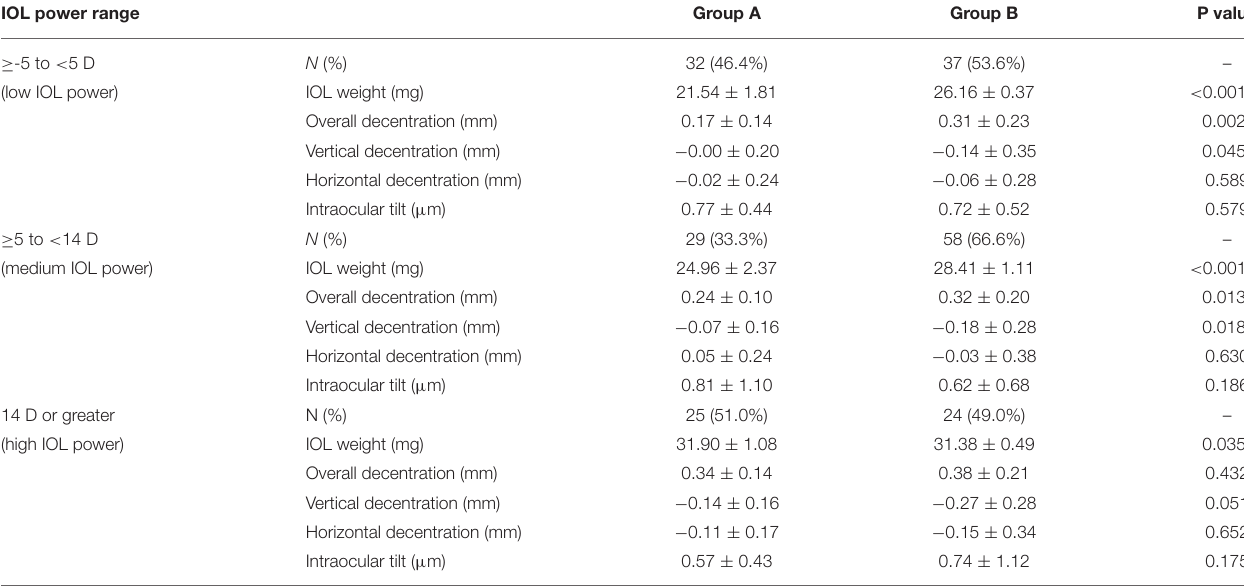
TABLE 2 | Comparisons of long-term intraocular lens (IOL) stability between Groups A and B with 3 different IOL power ranges. IOL power range Group A Group B P value